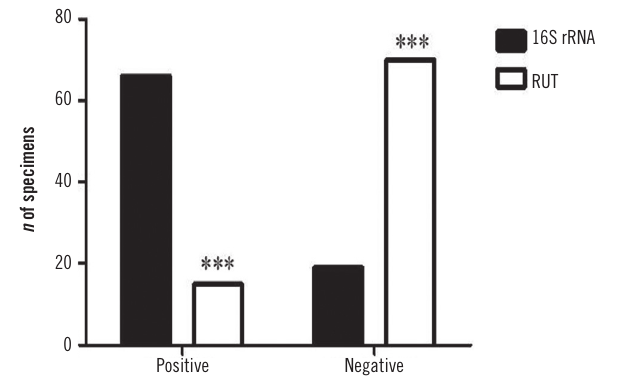
figurE 4 − Comparison between the number of samples and the results obtained by the molecular diagnostic method using the 16S rRNA gene (HpX/HpX1) and the RUT. There was a significant difference between the groups ( p < 0.0001)